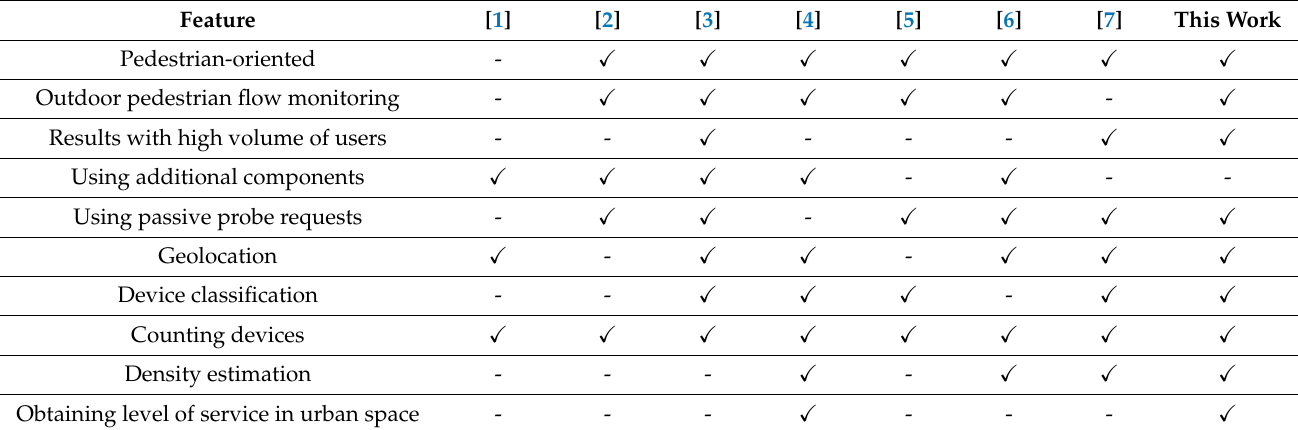
Table 1. Comparison of contributions of different analysis of pedestrian research